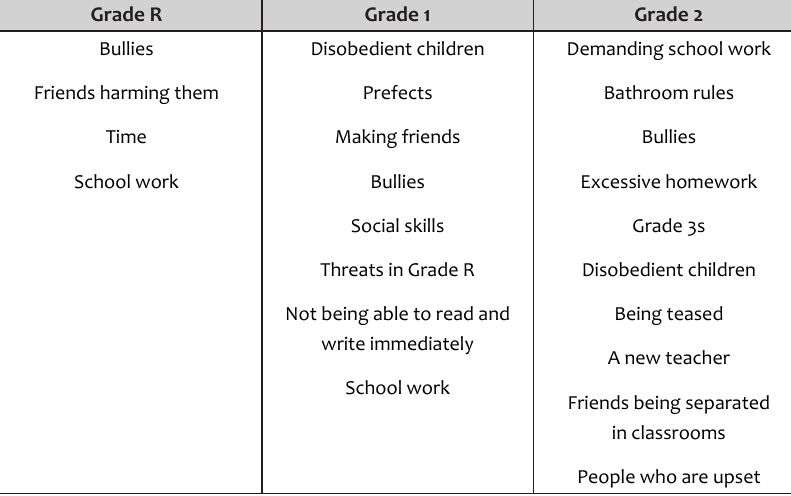
Table 2: Negative (-) stressors experienced by the participants Grade